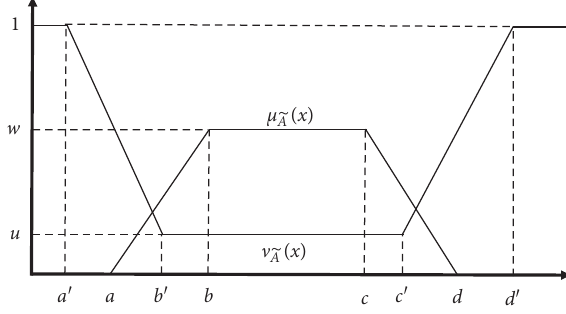
Figure 2: A TraIFN 􏽥 A � 〈( a,b, c,d ; w ) , ( a ′ , b ′ , c ′ ,d ′ ; u )〉 .